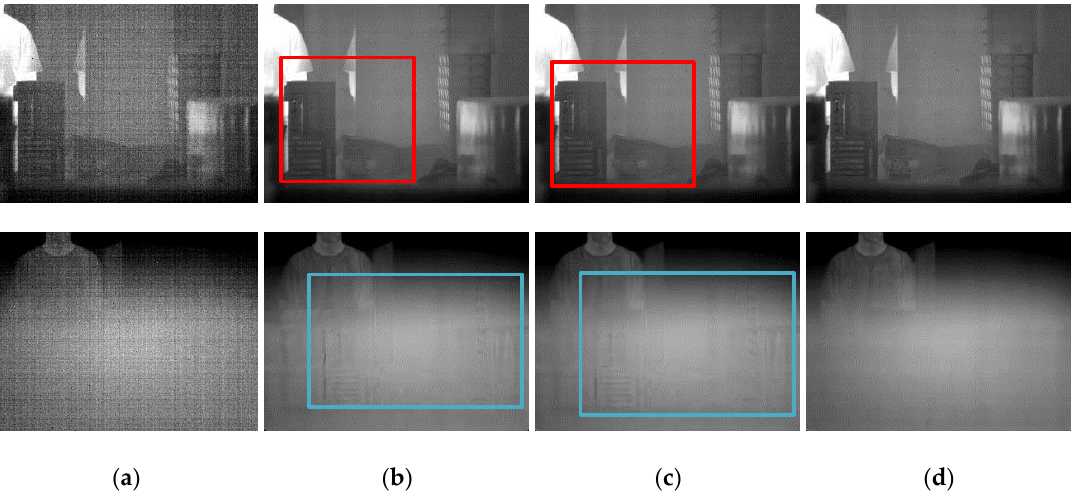
Figure 8. NUC performance comparison of the real nonuniformity infrared sequence: ( a ) un-corrected image; ( b ) Gated–LMS; ( c ) ST–LMS; ( d ) our image. The top row is the 906th frame, when the imager jittered toward the indoor scene. The bottom row is the 1965th frame, when the FOV was blocked by a hand.